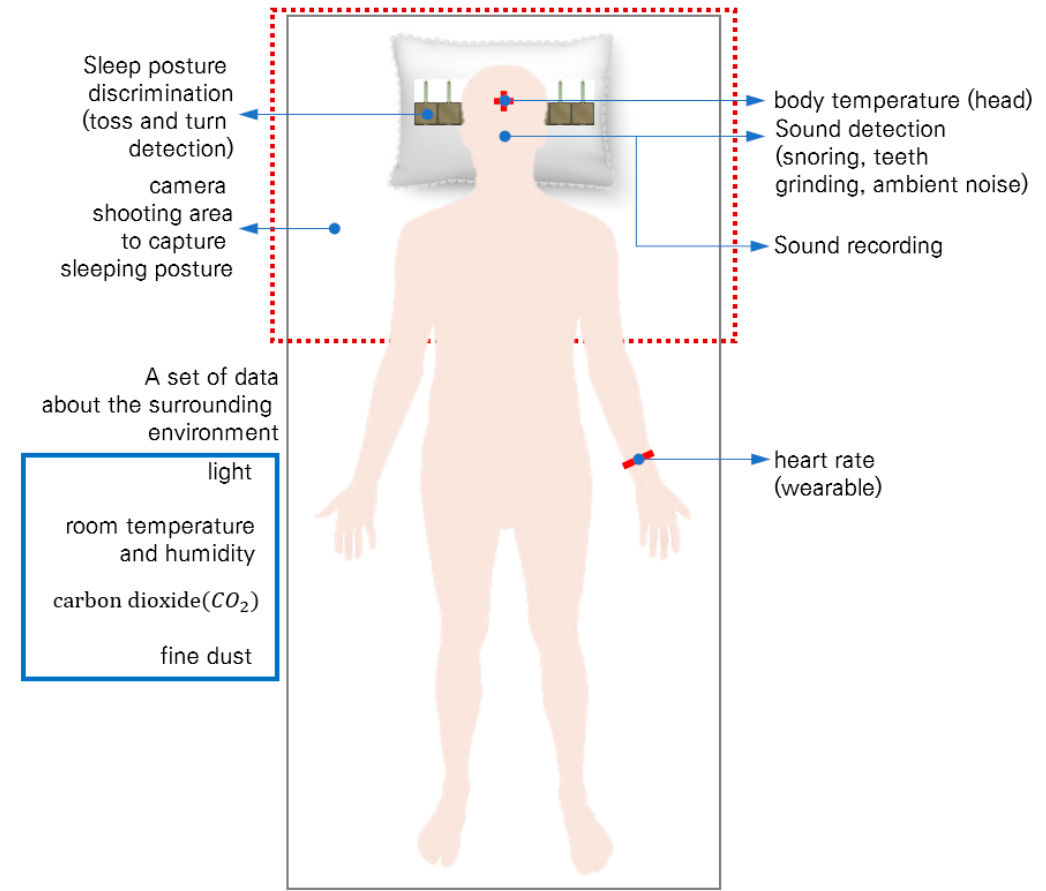
Figure 2. Sleep-related information for sleep pattern analysis.